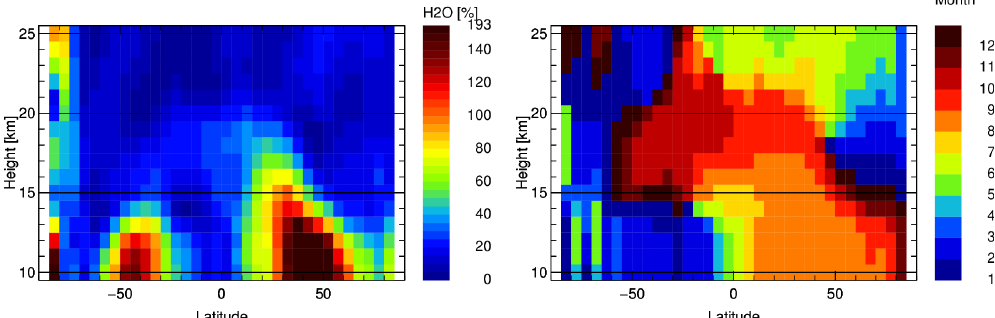
Figure 11. Amplitude and month of the maximum (1: January, 12: December) for the annual cycle from the multivariate linear regression applied to SCIAMACHY data on a 5 ◦ latitude and 1km height